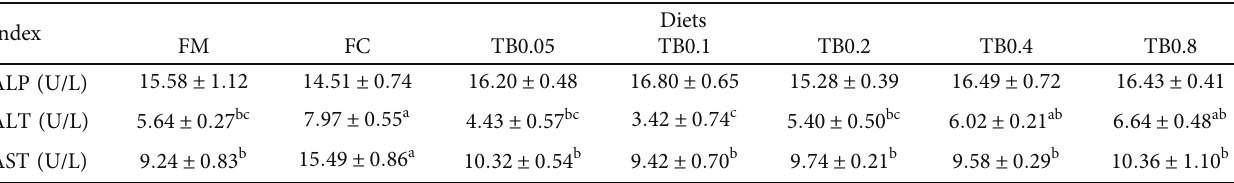
Table 6: E ff ects of tributyrin supplementation on serum indexes of juvenile large yellow croaker fed diets with high level of Clostridium autoethanogenum protein replacing fi sh meal ( means ± SEM, n = 3 ) 1